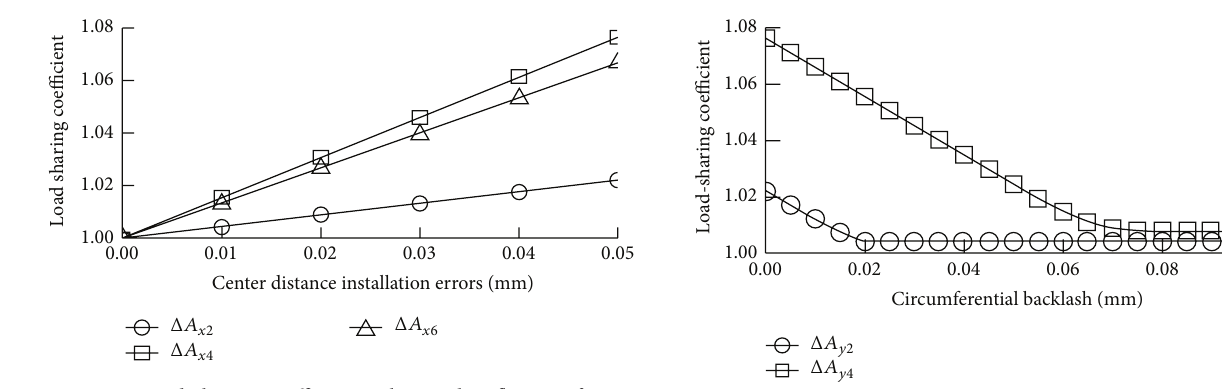
Figure 17: The load-sharing coefficient changed with circumferen- tial backlash.